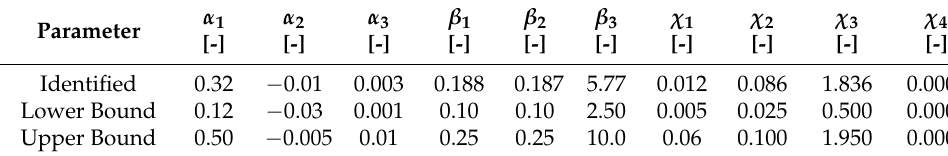
Table 7. Identified model parameters and search space for the HDR Element.